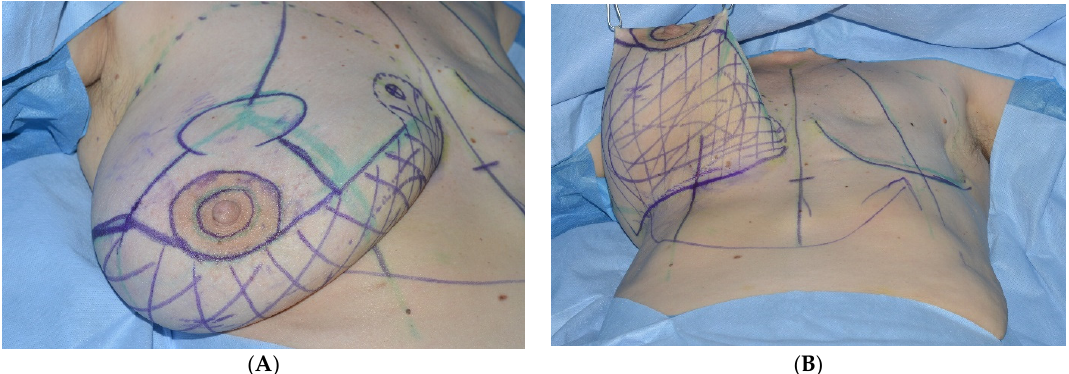
Figure 2. Preoperative Markings. ( A ) Incision planning according to a superiorly based reduction mammoplasty, ( B ) the dashed field represents the respective internal mammary artery perforator IMAP-flap angiosome.